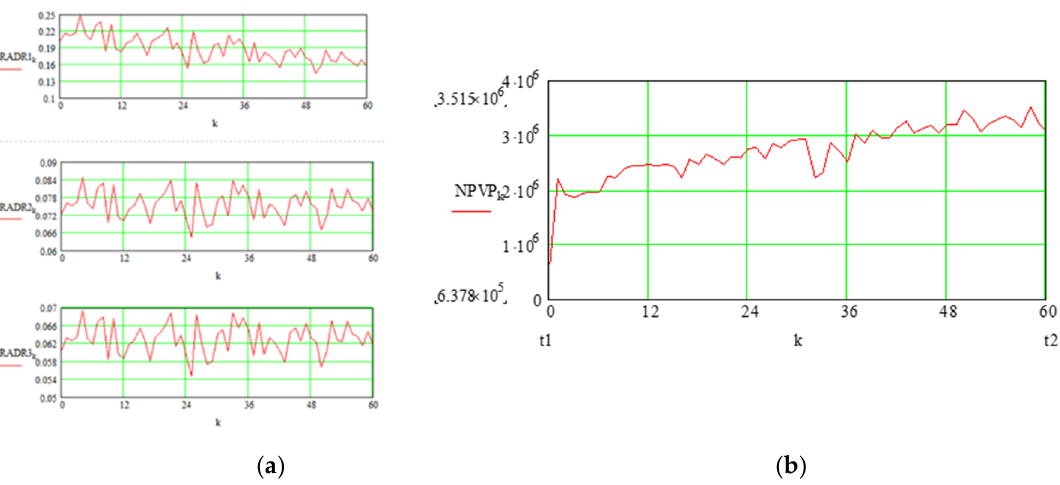
Figure 5. Dynamics of RADRs ( a ), and total NPV ( b ) dynamics for Scenario B1C (m = 1, σ = 0.10; term structure of the interest rate considered; interest rate seasonal rate fluctuations not considered).